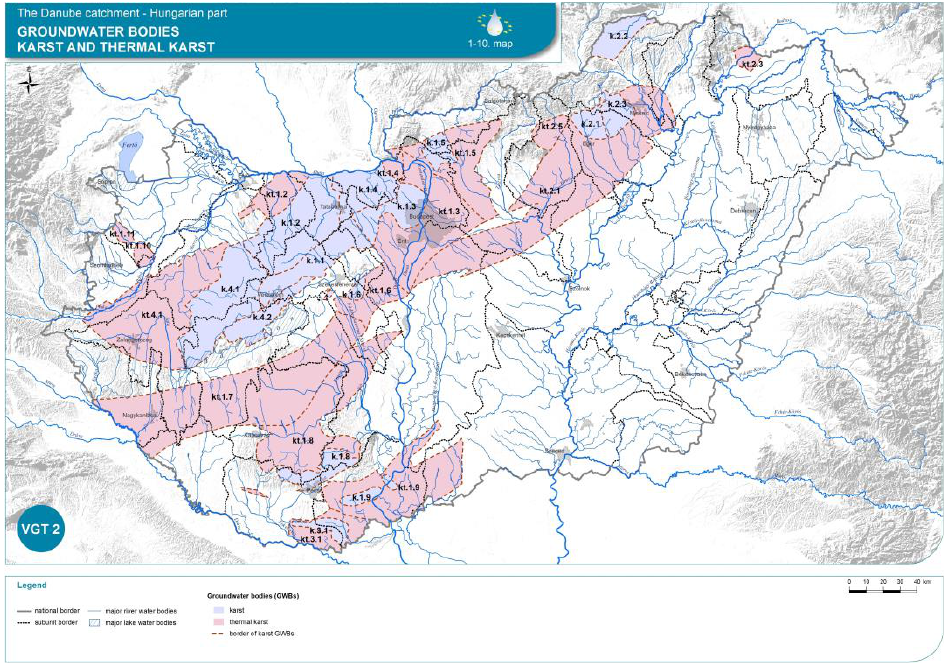
Figure 1. Twenty-nine Hungarian karst and thermal karst groundwater bodies were identified by the Hungarian River Basin Management Plan.